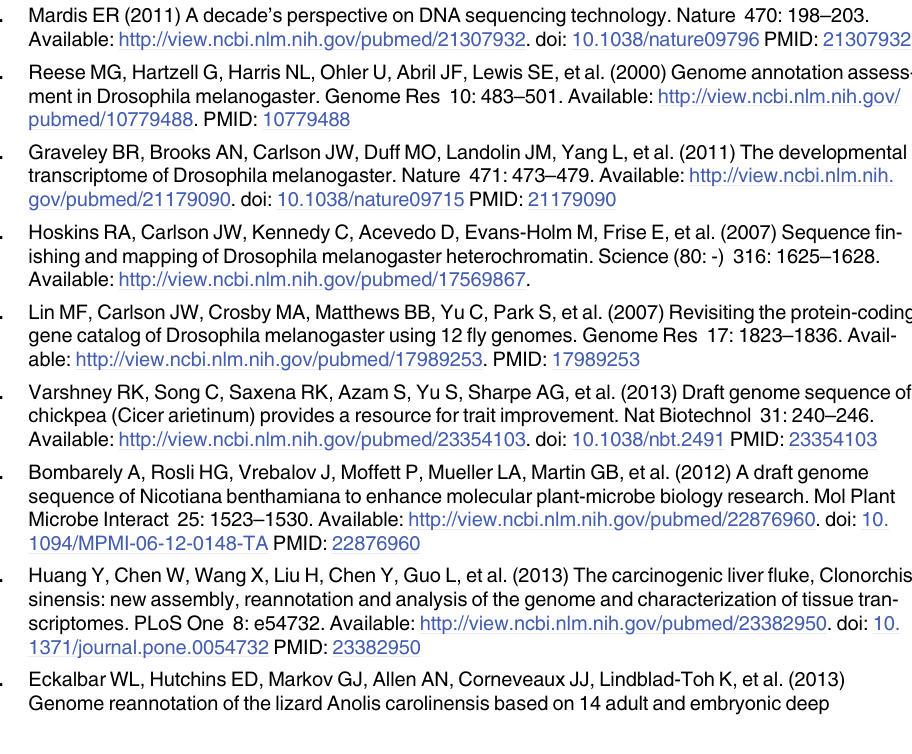
enriched with RNA-PET data extend 32bp upstream of RNA-Pol II peak. S1 Table. DNA-PET pairing statistics. S2 Table. RNA-PET clustering statistics. S3 Table. Primers